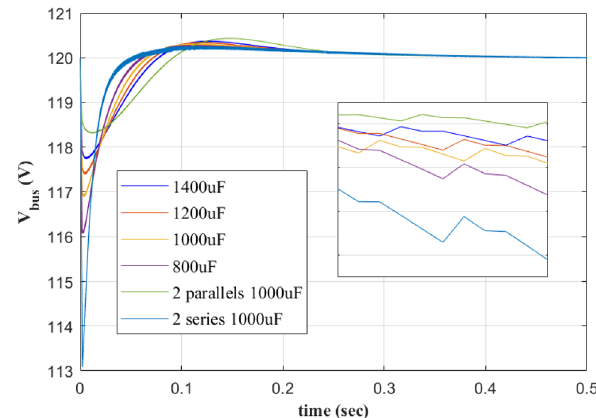
Fig. 13 Power curves of the load, the FC, the PV and the superca- pacitor